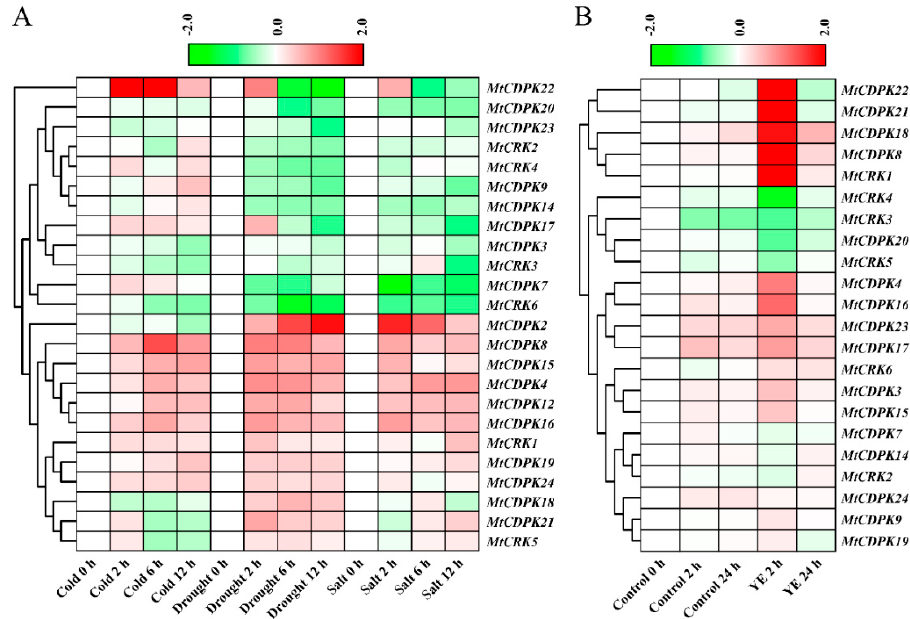
Figure 6. Expression patterns of MtCDPK and MtCRK genes under different abiotic treatments ( A ) and biotic treatment ( B ). The transcript levels after treatments were rescaled relative to that untreated time (at 0 h) when calculating the relative expression levels. The heat map portrayed the relative expressions after log 2 transformed. The corresponding group of each gene was shown on the left. YE, yeast elicitor.